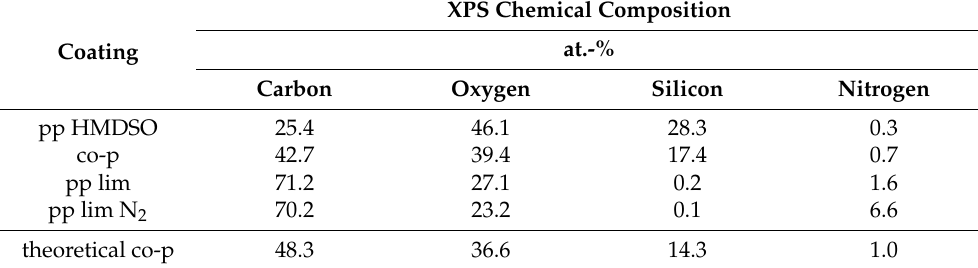
Table 1. XPS data of the chemical composition of pp HMDSO (10 g · h − 1 ), lim (10 g · h − 1 ) with air